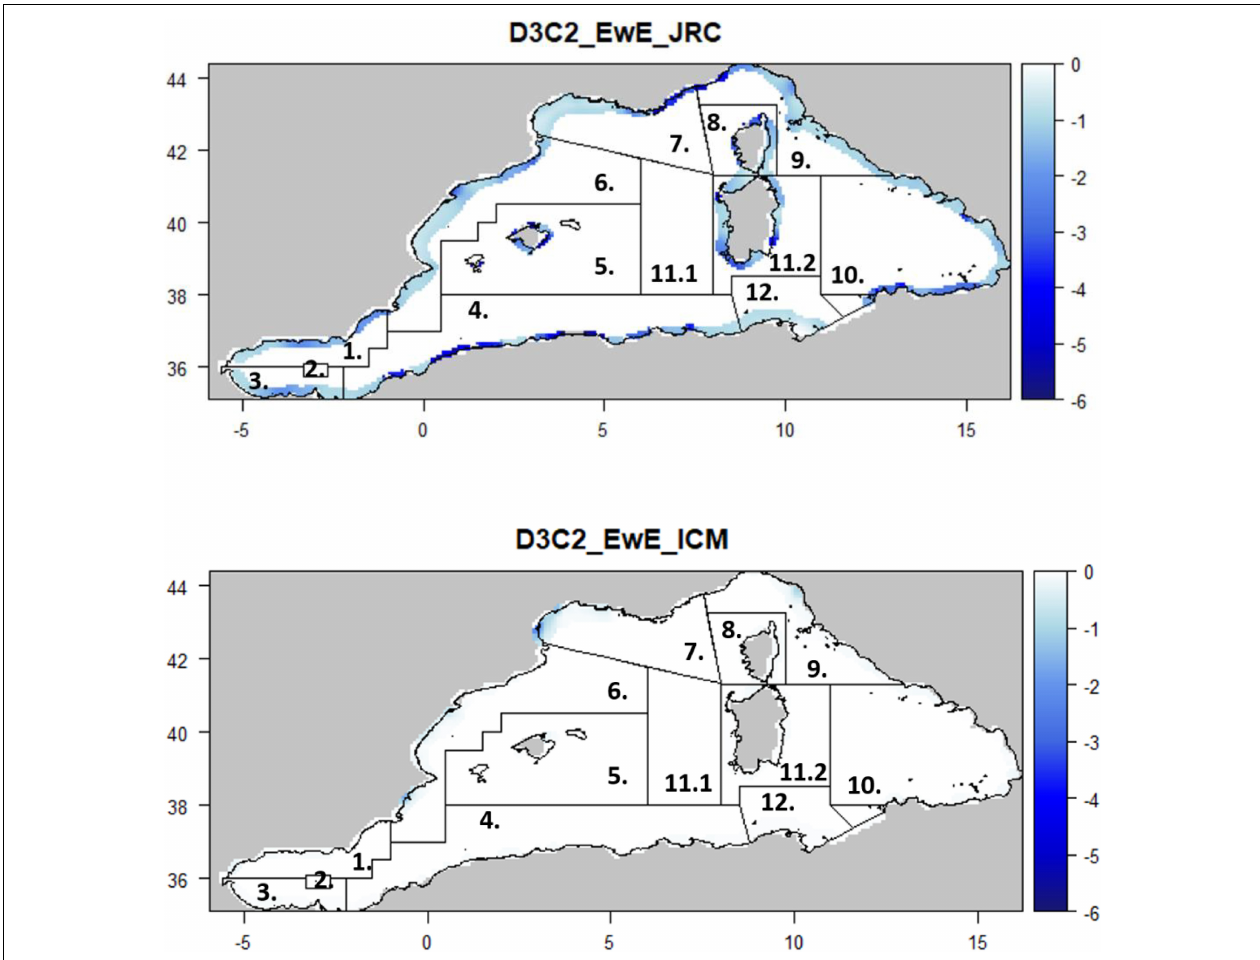
FIGURE 4 | Maps representing the mean change (%) for the Spawning stock biomass of a commercially important small pelagic fish (D3C2) per GSA (# 1. Northern Alboran Sea; 2. Alboran Island; 3. Southern Alboran Sea; 4. Algeria; 5. Balearic Islands; 6. Northern Spain; 7. Gulf of Lion; 8. Corsica; 9. Ligurian and Tyrrhenian Seas; 10. South and Central Tyrrhenian; 11.1. Sardinia West; 11.2. Sardinia East; 12. Northern Tunisia) and per model